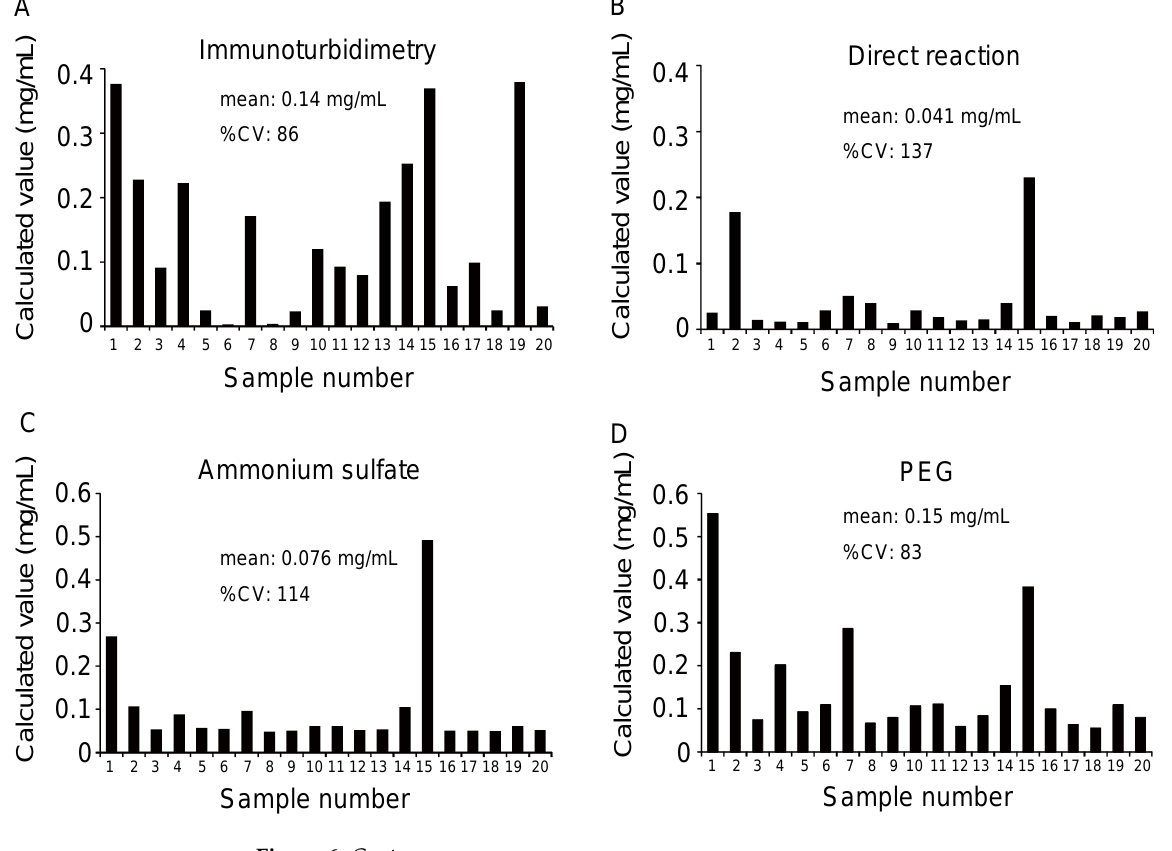
Figure 6. Comparison of albumin concentrations quantified by various methods. ( A ) Urine sample was quantified by an immunoturbidimetric assay. ( B ) Urine samples and albumin purified by ( C ) ammonium sulfate precipitation, ( D ) polyethylene glycol (PEG) precipitation, and ( E ) acetone pre- cipitation were reacted with luciferin, and albumin concentration was calculated based on lumi- nescence. The horizontal axis represents the sample number, and the vertical axis represents the calculated albumin concentration.